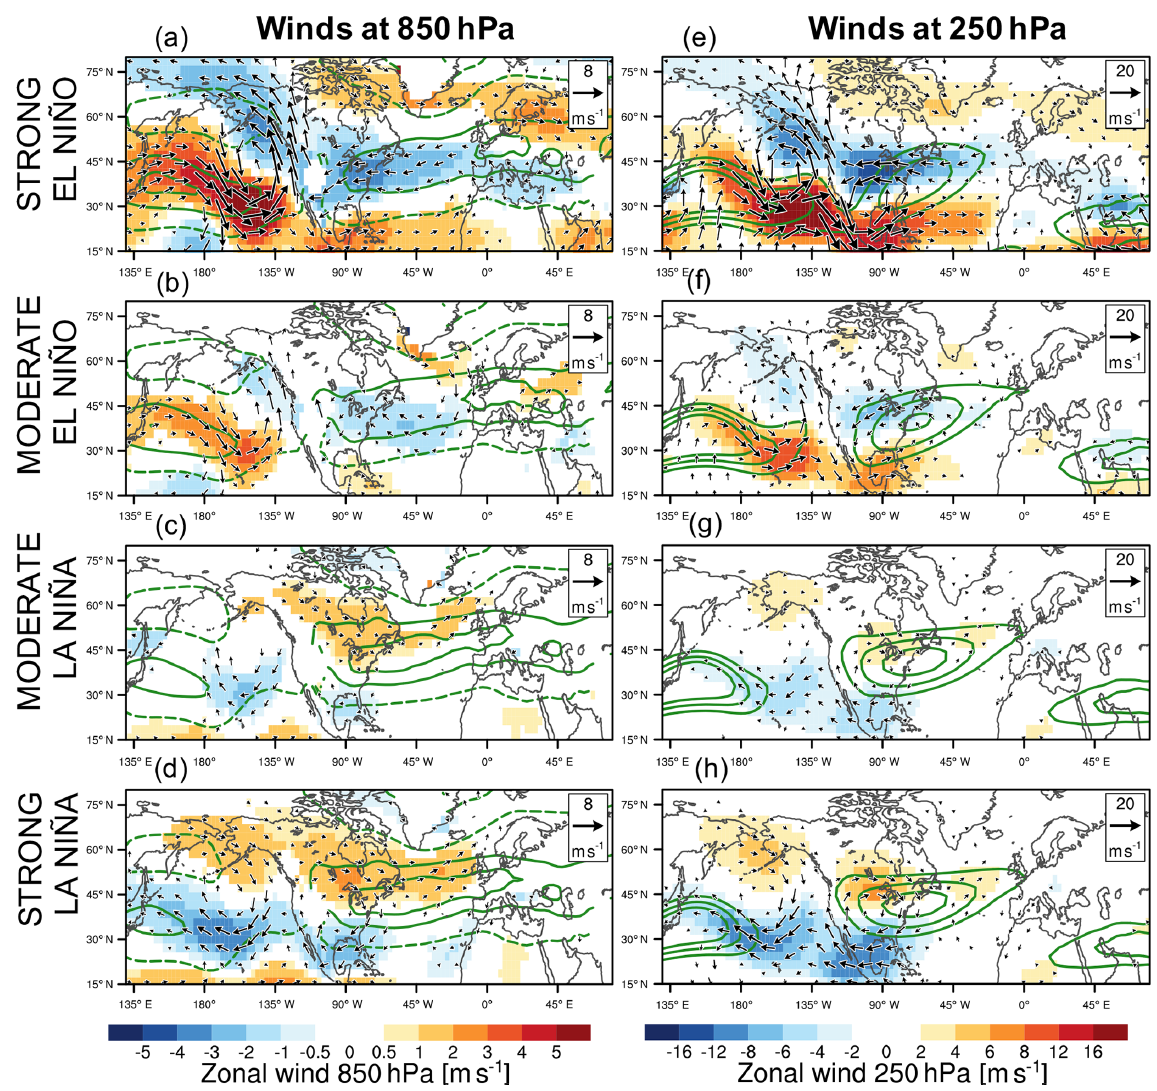
Figure 3. As in Fig. 2 but for the zonal wind (a–d) at 850hPa and (e–h) at 250hPa. Arrows display the zonal and meridional wind anomalies. Green contour lines show the absolute values of the zonal wind component for each simulation (0 (dashed), 5, and 15ms − 1 in (a–d) and 30, 40, and 50ms − 1 in (e–h) , respectively). Only statistically significant values above the 95% level are